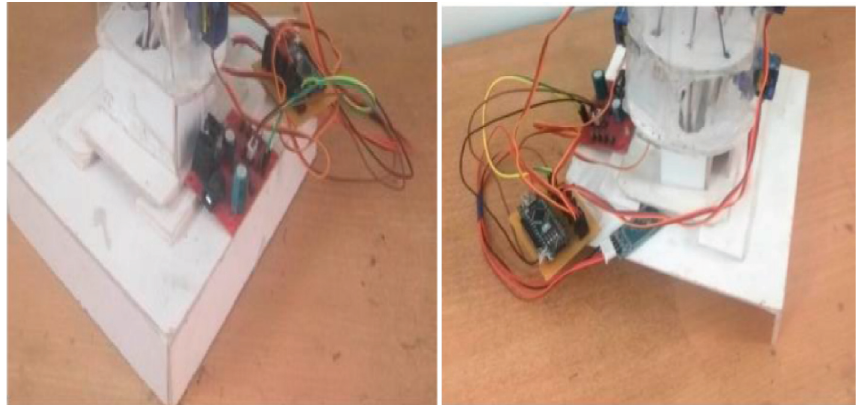
Figure 7: Power supply and microcontroller interface with